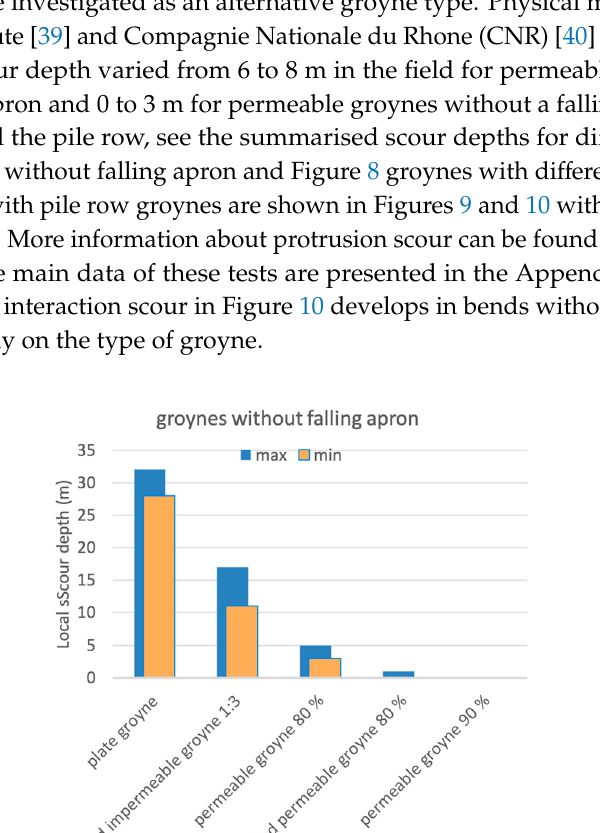
Figure 8. The maximum local scour depth near different types of groynes with various types falling aprons in physical model tests. Figure 9. Small local scour hole (0 m to 1 m) near a pile row without bed protection or falling apron, only some scour around the piles, test C-T2-1 in Compagnie Nationale du Rhone ( CNR), France [40], (photograph taken by CNR for project FAP 21/22).